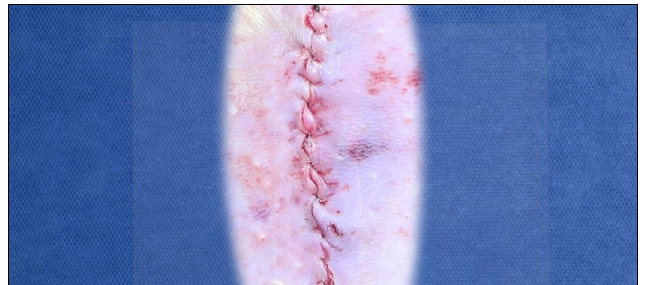
Figure 4 - Synthesis of the skin with simple overcast using the Monocryl